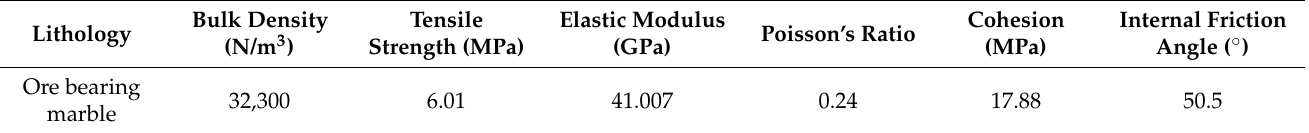
Table 1. Results of physical and mechanical properties of 609 horizontal ore and rock.